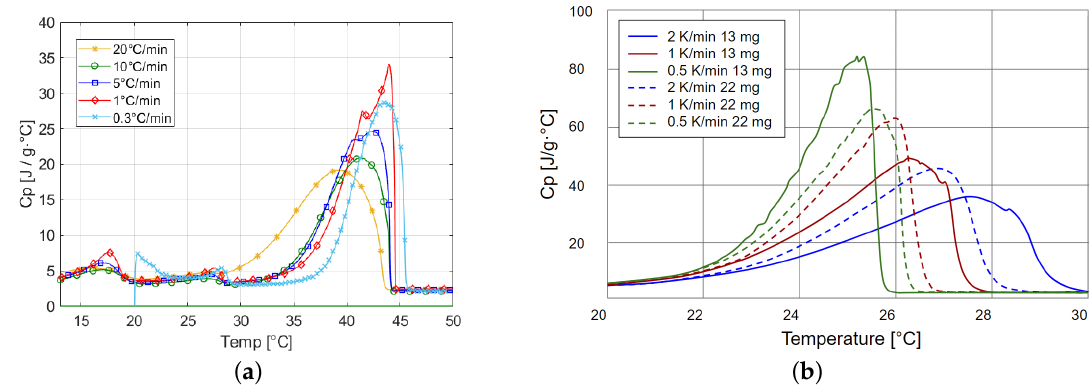
Figure 15. ( a ) Specific heat capacity of the PCM RT45 varying heating rates and sample mass; ( b ) Results for the heat capacity of a PCM varying heating rates and sample mass, adapted from